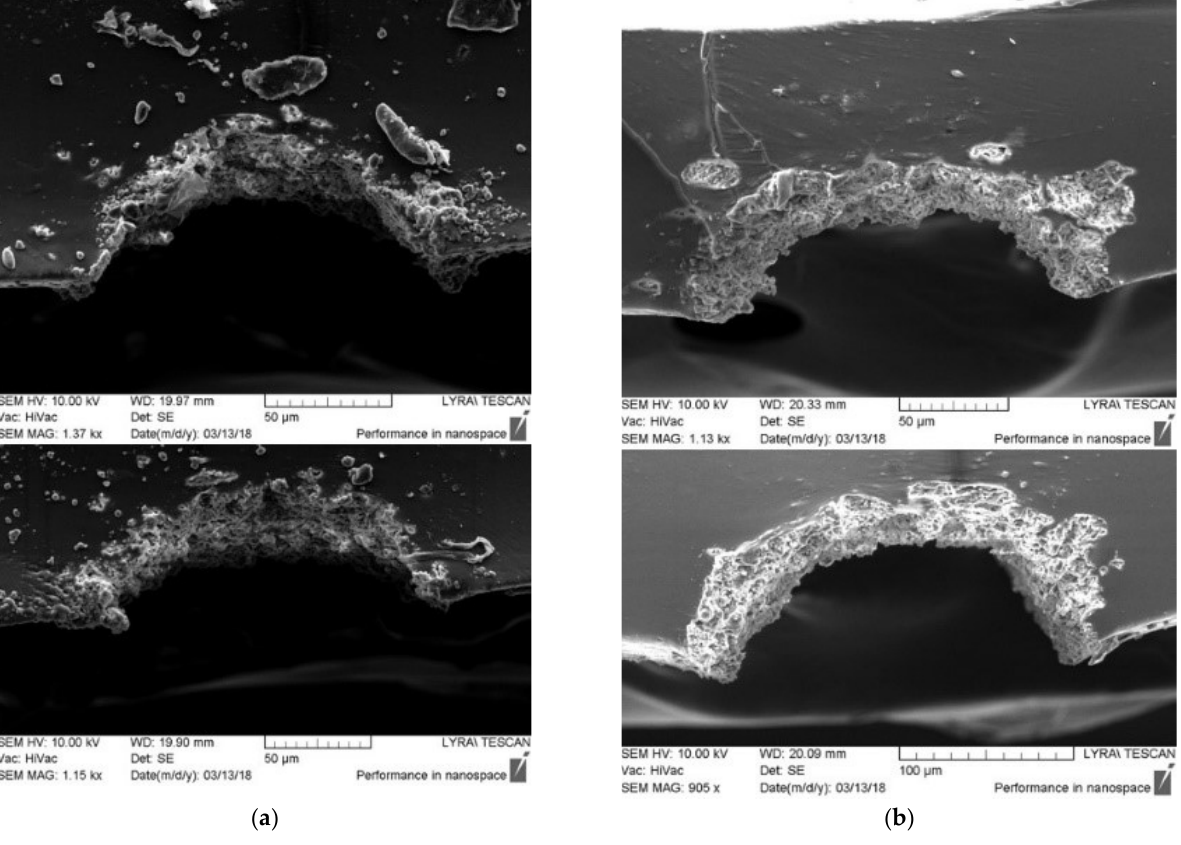
Figure 6. SEM cross section images of the laser tracks produced after ns-laser ablation of PDMS polymer in water present the formation of Profiles with regular contours, and symmetric and wide-opened U-shape, with: ( a ) 266 nm and fluences higher than 28.07 J · cm − 2 ; ( b ) 355 nm and fluences higher than 21.75 J · cm − 2